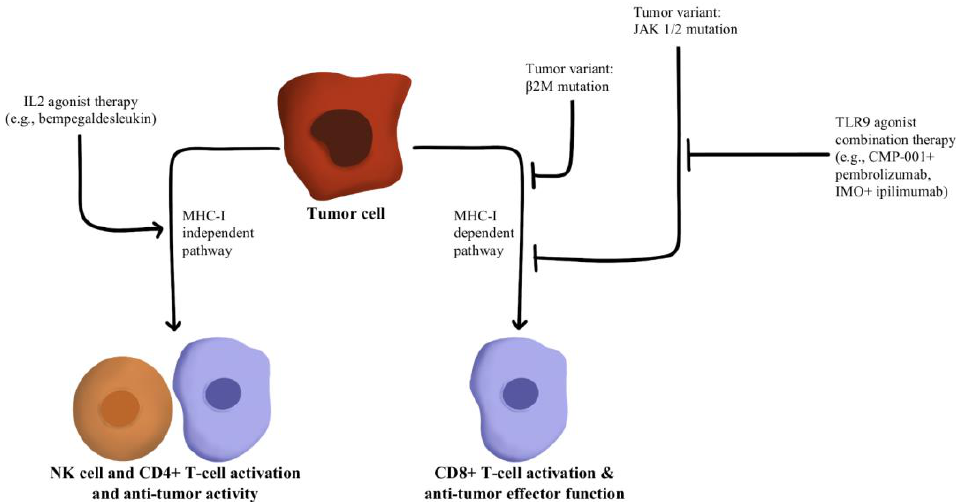
Figure 6. Diagram of MHC-I-dependent and MHC-I-independent pathway modulation [88–95]. Illustrated by Kaitlyn Mi of The Dartmouth Institute.